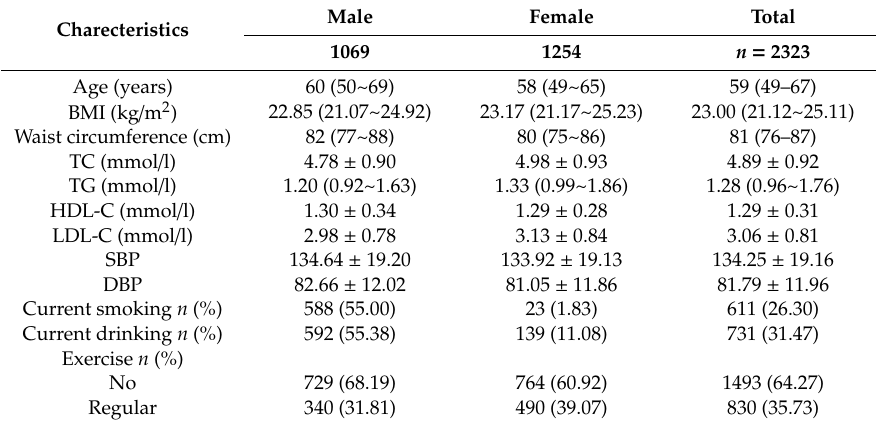
Table 1. General characteristics, serum lipid levels, and lifestyles.